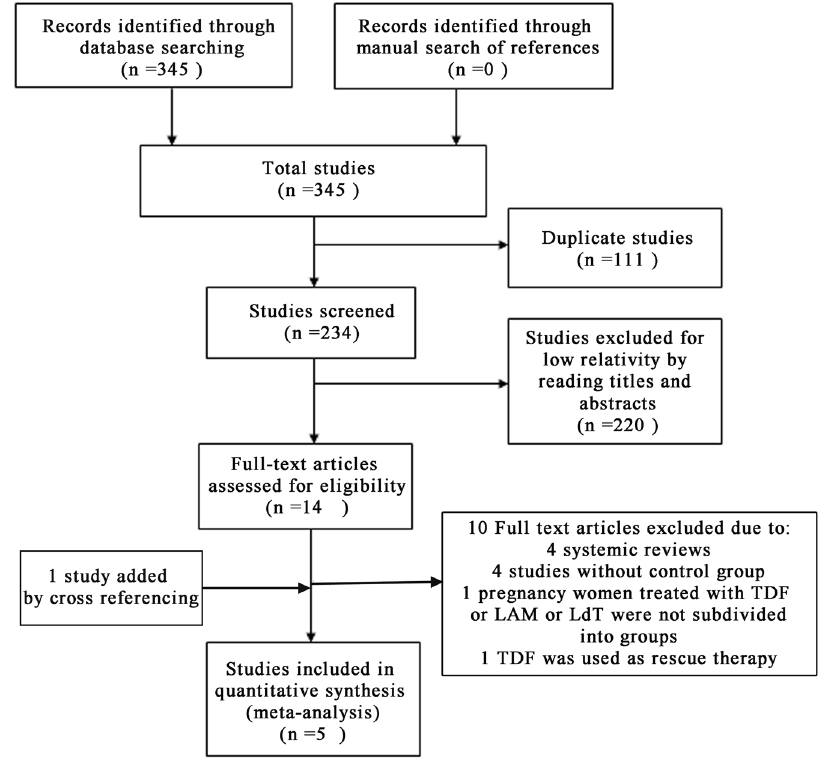
Figure 1. Flowchart of study selection 35